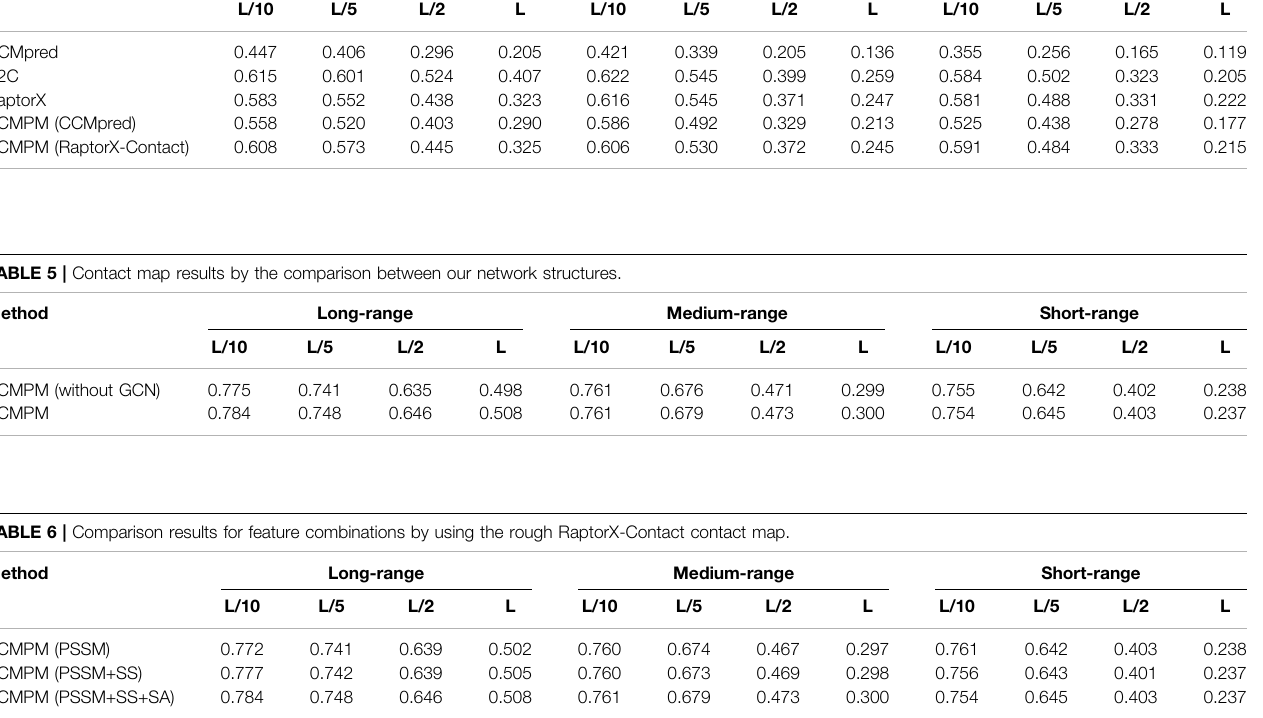
TABLE 4 | Contact map results by four different methods on the CASP12 testing dataset. Method